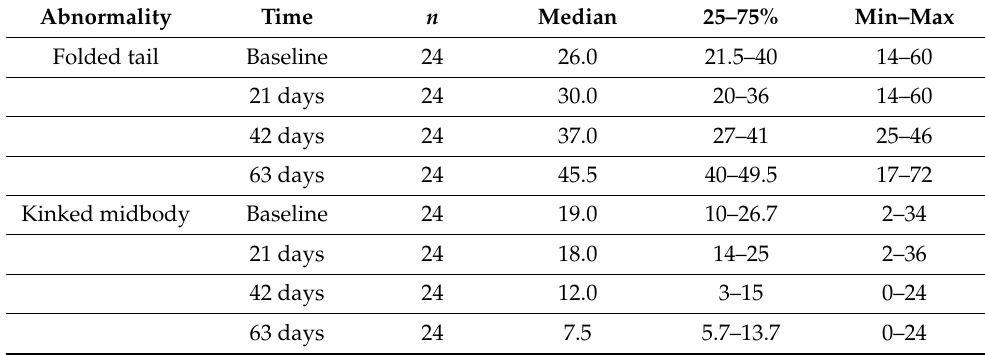
Table 8. Abnormal spermatozoa morphology (% total morphology) that differed over time.